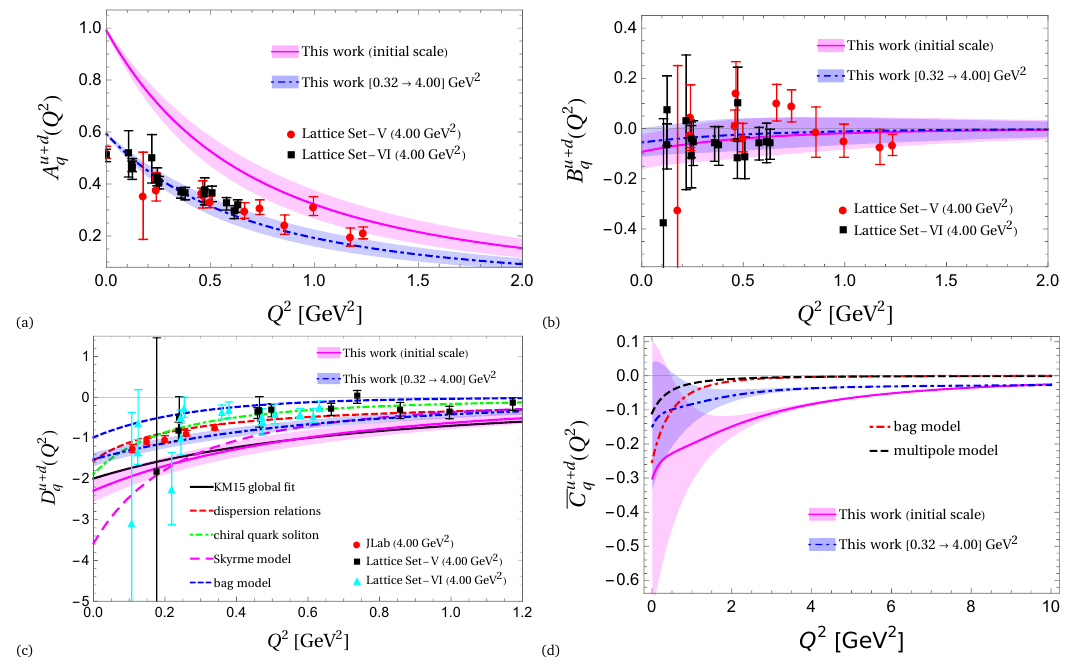
Figure 1: The plots of the four GFFs as functions of Q 2 . The solid magenta lines with magenta bands are the results at the initial scale, while the dash-dotted blue lines with blue bands represent the results at µ 2 = 4 GeV 2 evolved from the initial scale µ 2 = 0.32 GeV 2 0